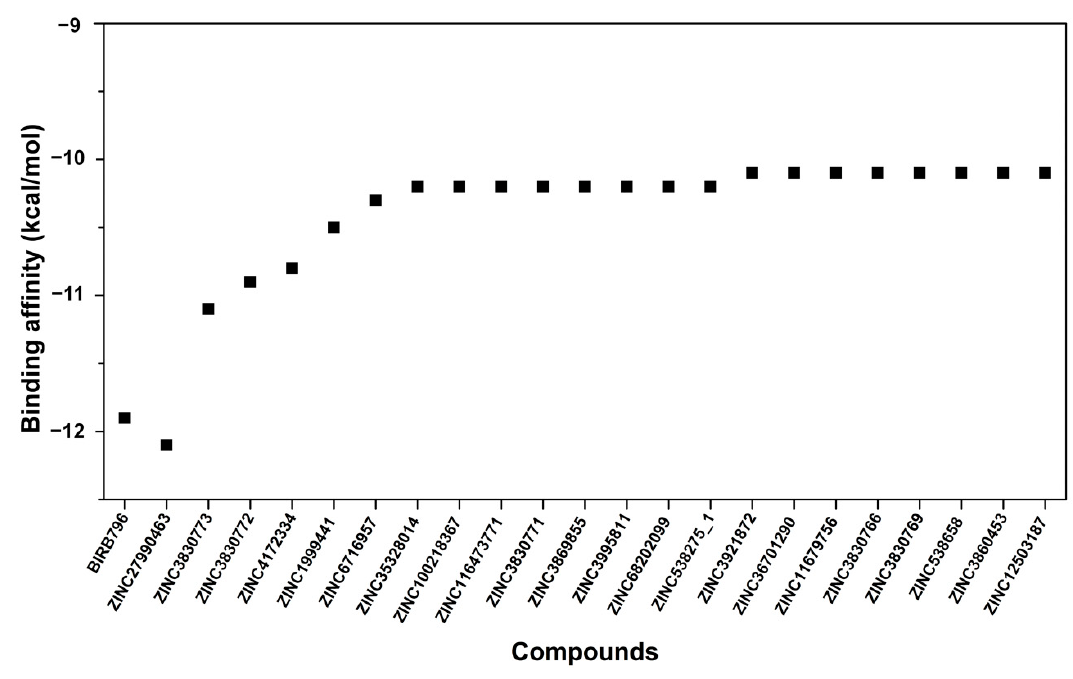
Figure 3. Binding affinity in kcal/mol of selected first-round screened compounds that were suc- cessfully docked into the focused allosteric site of p38 α MAPK compared to BIRB796. Note that the prediction was based upon the scoring function implemented in the Autodock VinaXB, Sirimulla Research Group at the University of Texas at El Paso, Texas, USA.